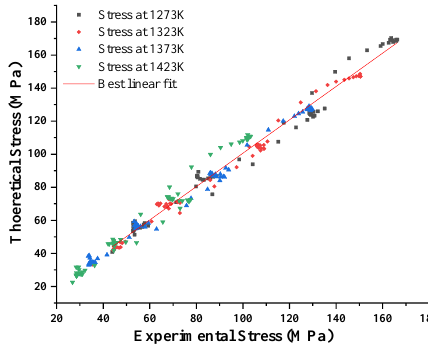
Figure 8. Correlation between experimental and theoretical values of flow stress.